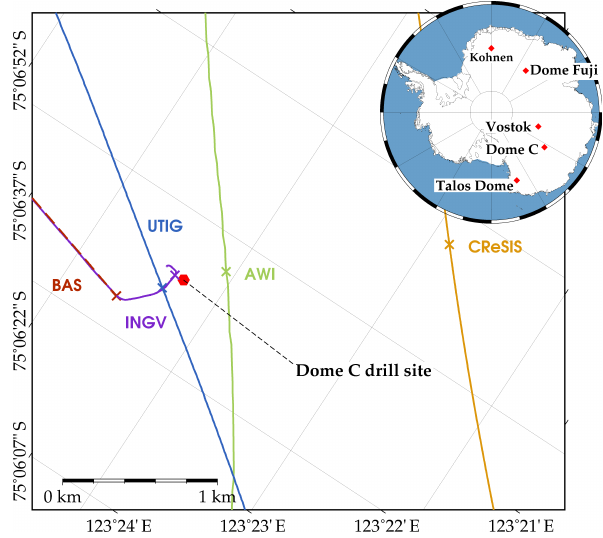
Figure 1. The deep drill sites in East Antarctica and close-up to Dome C with the RES profiles. The crosses mark each profile’s closest trace to the drill site. The location of the EDC drill site is marked by the red